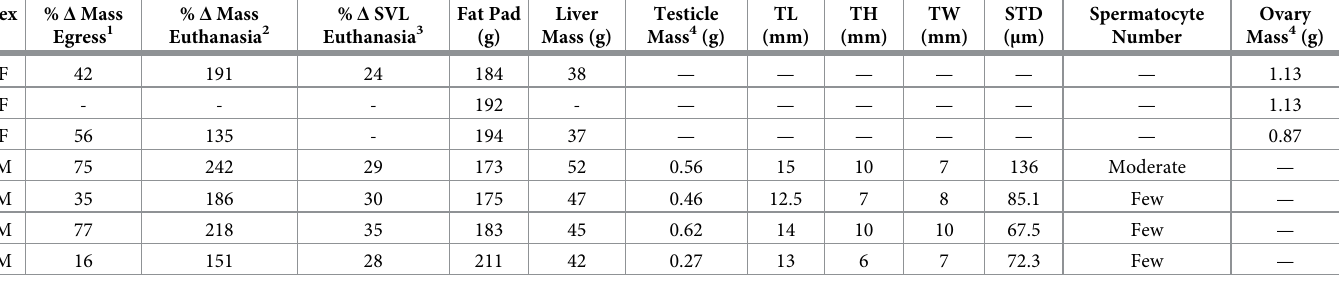
Table 2. Morphology data of surviving tegus ( Salvator merianae ). Characterization of growth and morphology data for the seven of twelve Argentine Black and White Tegus ( Salvator merianae ) that were captured in May or June 2017, survived a full year in semi-natural enclosures in Auburn, AL and were euthanized on 23 August